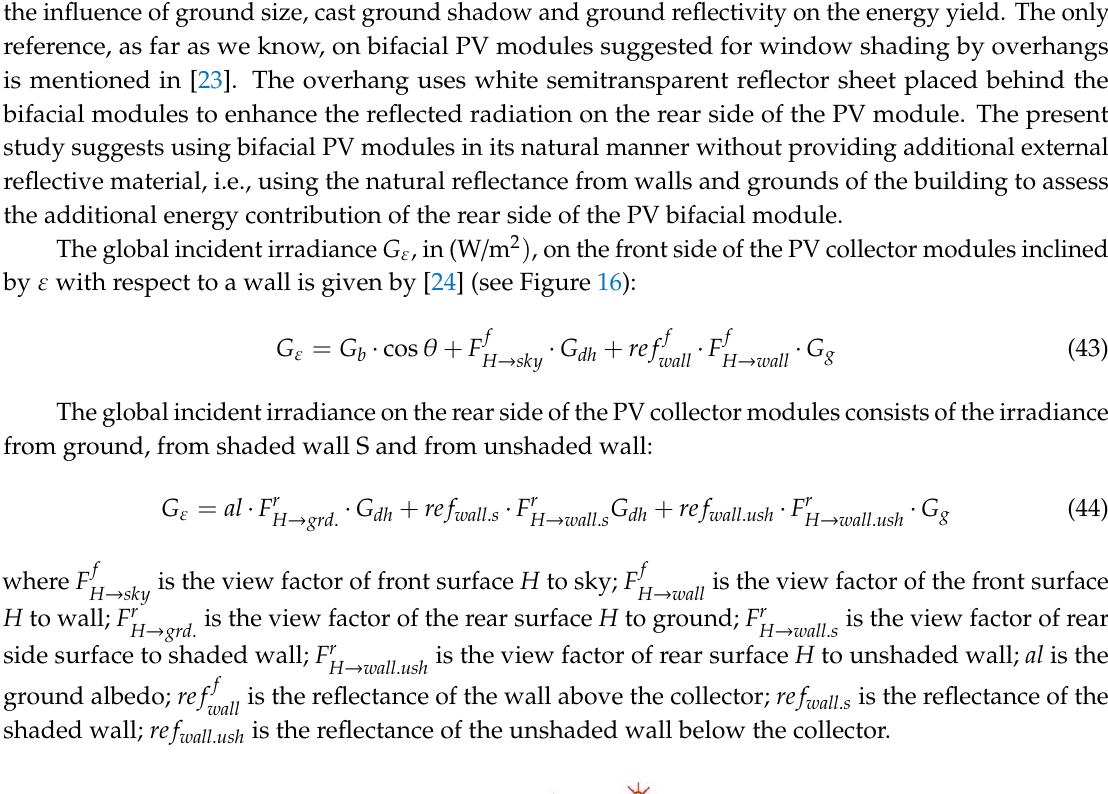
Note that the shaded wall S varies with time during the day with the position of the sun, see Figure